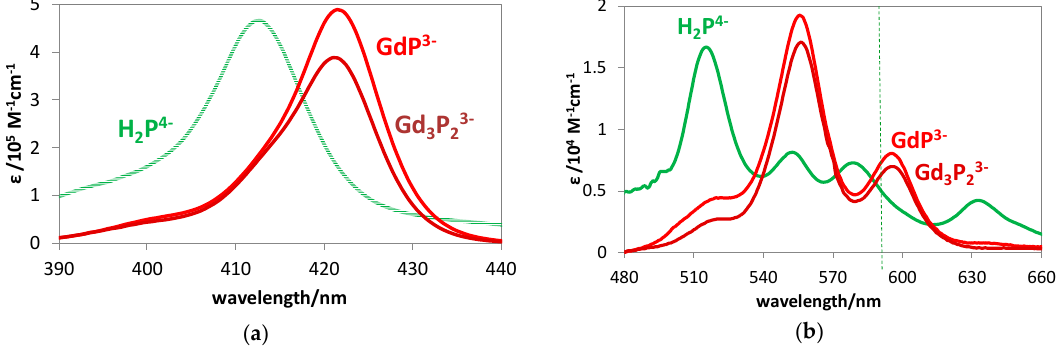
Figure 3. Molar absorption spectra of GdP 3 − and Gd 3 P 23 − compared with those of the free-base porphyrin in the ( a ) Soret-range and ( b ) Q-range.